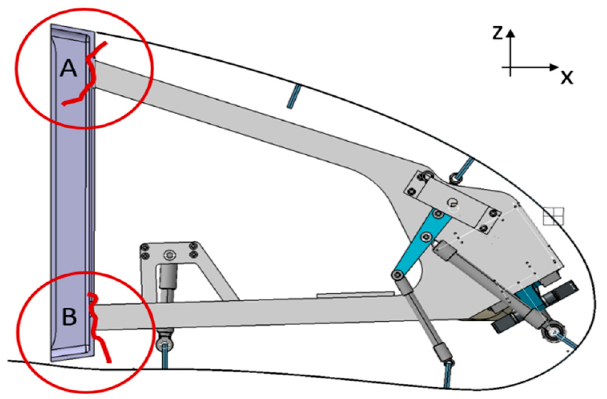
Figure 29. Positioning of interfaces between MLE and front